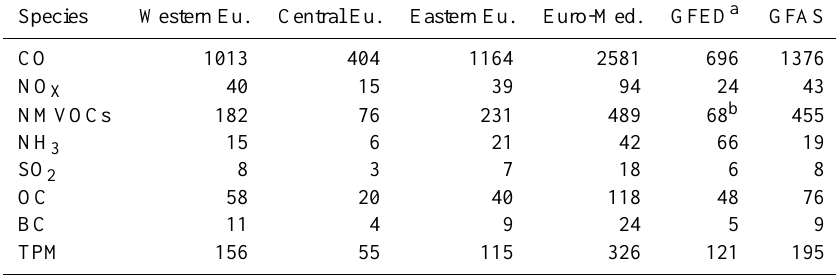
Table 8. Average (2003–2012) total annual emissions in Gg for different pollutants and regions of the Euro-Mediterranean (Euro- Mediterranean: latitudes between 36 and 48 ◦ N, divided into 3 subdomains: West from 10 ◦ W to 5 ◦ E, Central from 5 to 20 ◦ E, and East from 20 to 35 ◦ E.). The average total emissions from the GFED and GFAS inventories are provided for comparison (total within the Euro- Mediterranean domain). Species Western Eu. Central Eu.